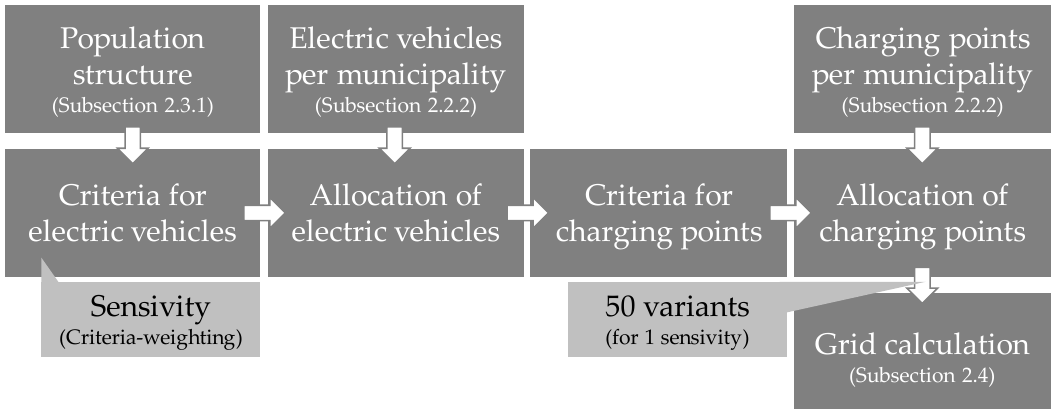
Figure 3. Vehicle allocation flowchart.